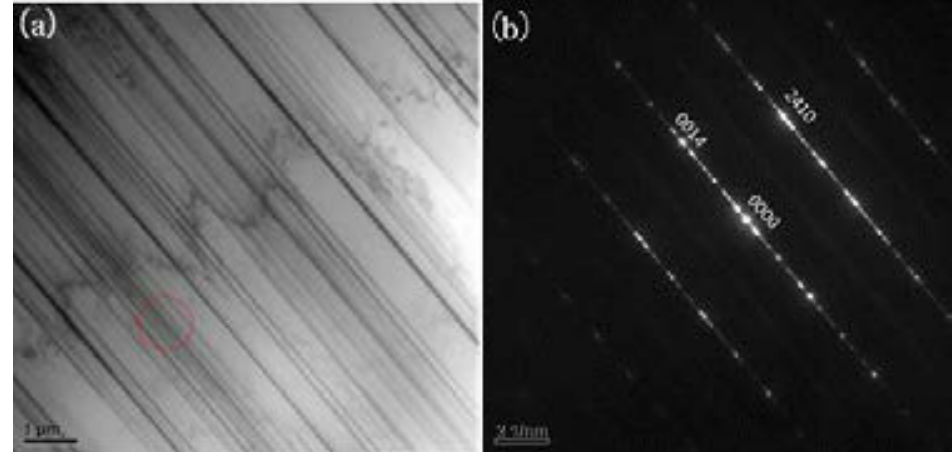
Zn Y alloy; (b) The [ 98.5 0.5 1